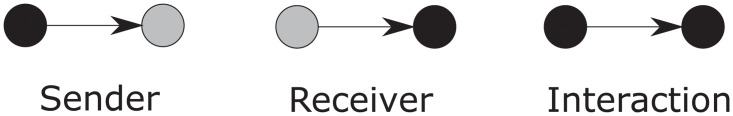
Binary attribute configurations.The dark nodes represent actors with the binary attribute, and the lighter shaded nodes represent actors with or without the attribute.